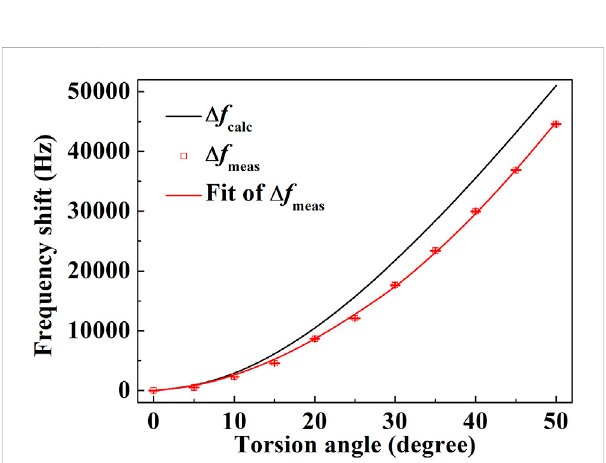
FIGURE 6 Measured and calculated mechanical resonant frequency shifts of the sensor as a function of torsion